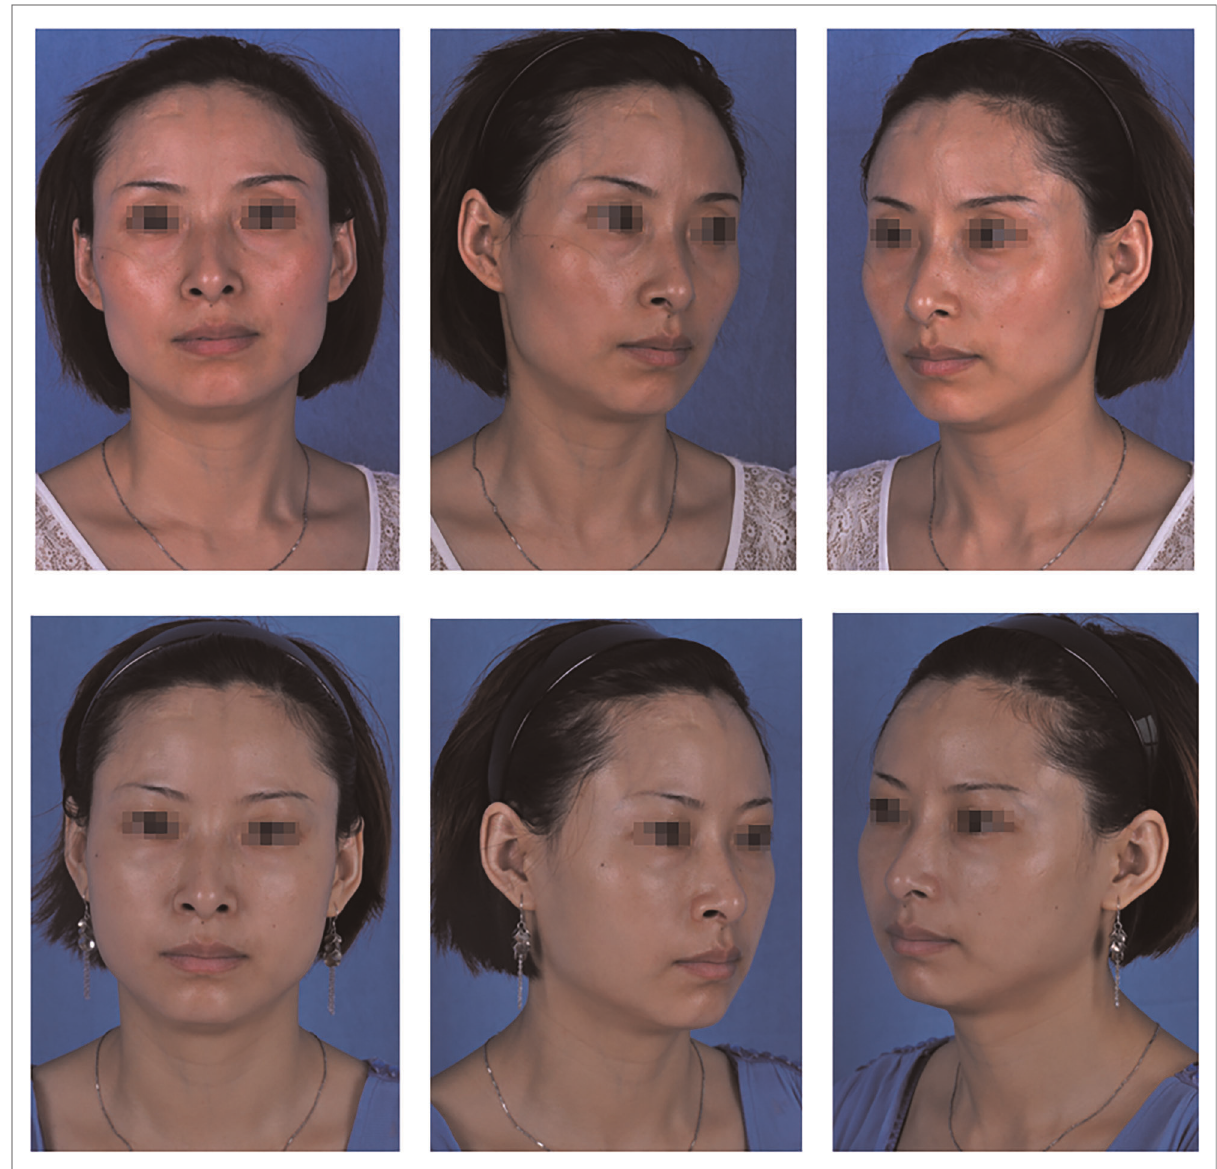
FIGURE 3 A 36-year-old patient: (top) preoperative view; (bottom) postoperative view 6 months after fat graft combined with PRF to the upper and lower eyelids, cheek, nasolabial folds and temporal regions, and 4, 3, 6, 4 and 20 ml of PRF-assisted fat were lipotransferred into each region (bilateral),